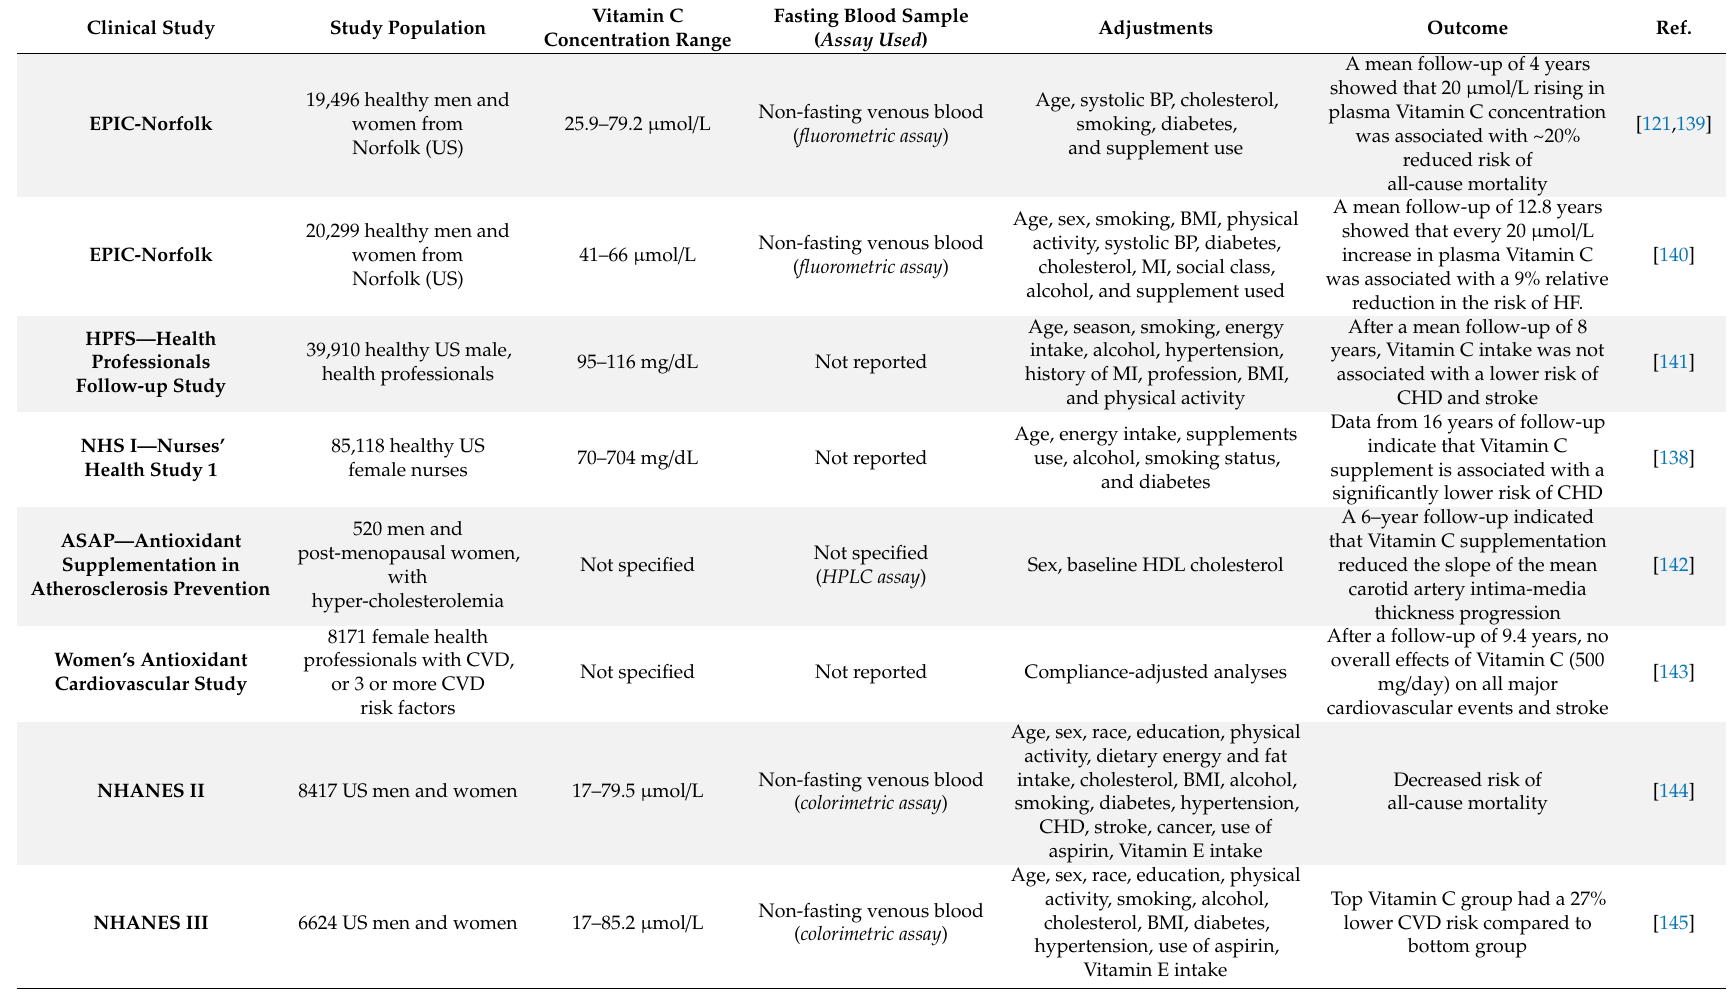
Table 1. Major studies investigating the association between vitamin C and cardiovascular disease